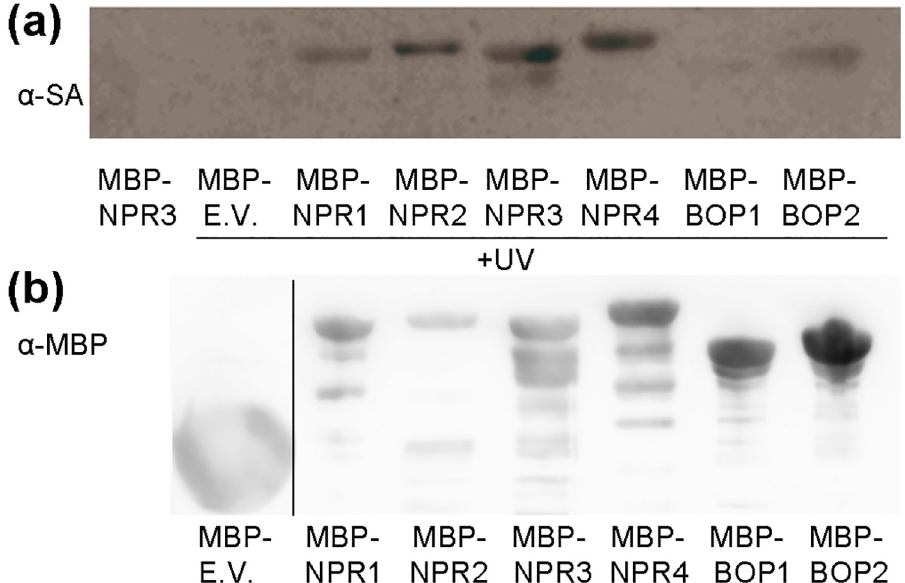
Fig 9. SA binding of the NPR1 paralogs. (a) Purified recombinant proteins were incubated with 4-AzSA, then treated with UV light. 4-AzSA-cross-linked proteins were detected by immunoblot analysis with anti-SA antibody. The first line corresponds to a negative control, where the UV light was omitted. (b) Loading control, the same amount of protein used in A was detected with an anti-MBP. The image was cut to show the MBP empty vector, as indicated by the vertical line.